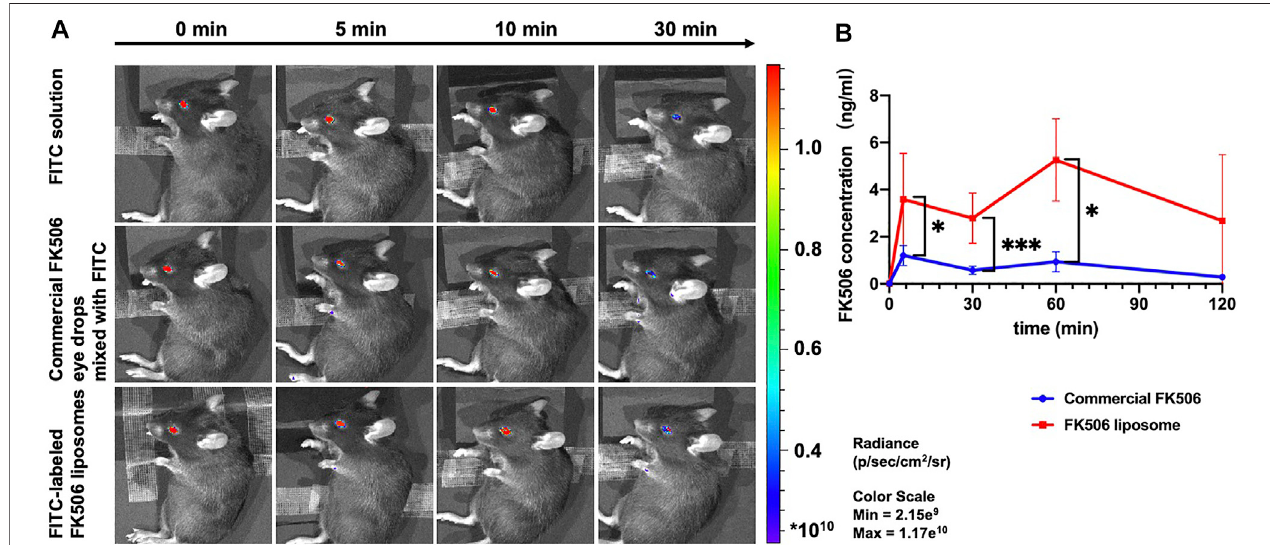
FIGURE 4 | In vivo ocular retention evaluation of FK506 liposomes in C57BL/6 mice and trans-corneal FK506 amount change in New Zealand rabbits. (A) In vivo fl uorescence images of FITC solution, commercial FK506 eye drops mixed with FITC, and FITC-labeled FK506 liposomes at 0, 5, 10, and 30 min. (B) In vivo trans- corneal FK506 amount changes of commercial FK506 eye drops (blue) and FK506 liposomes (red) after administration. Quantitative analysis of FK506 concentration in the cornea at 5, 30 min, 1 h, and 2 h. * P < .05 and ** p < .01.